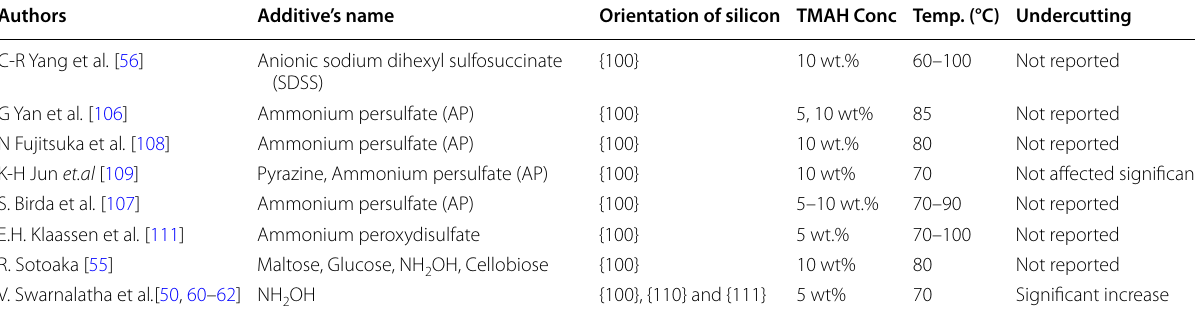
Table 6 The effect of various kinds of additives on the undercutting at convex corners in TMAH